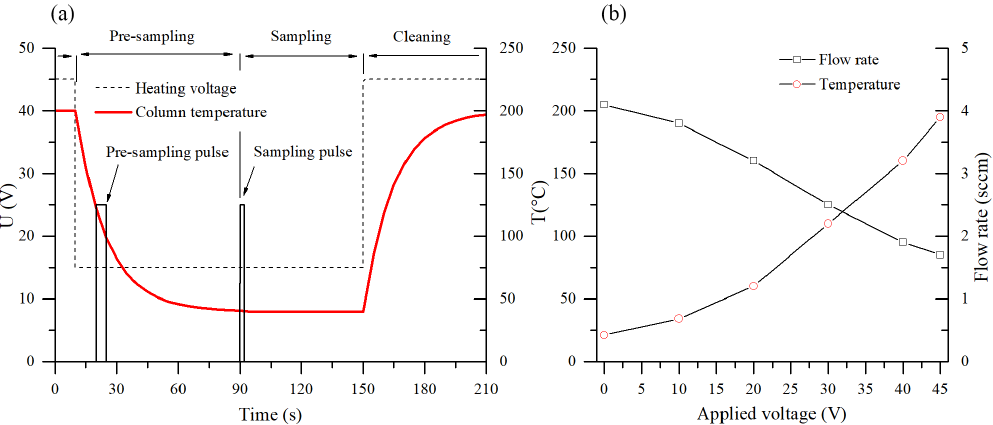
Figure 2. (a) The applied heating voltage (dashed) and the temperature profile of the column (red) during the fast GC cycle. The pulses indicate the opening of valve EV3 during the pre-sampling and the sampling periods. (b) The increase in the column temperature and the related decrease in the carrier gas flow rate with the heating voltage.